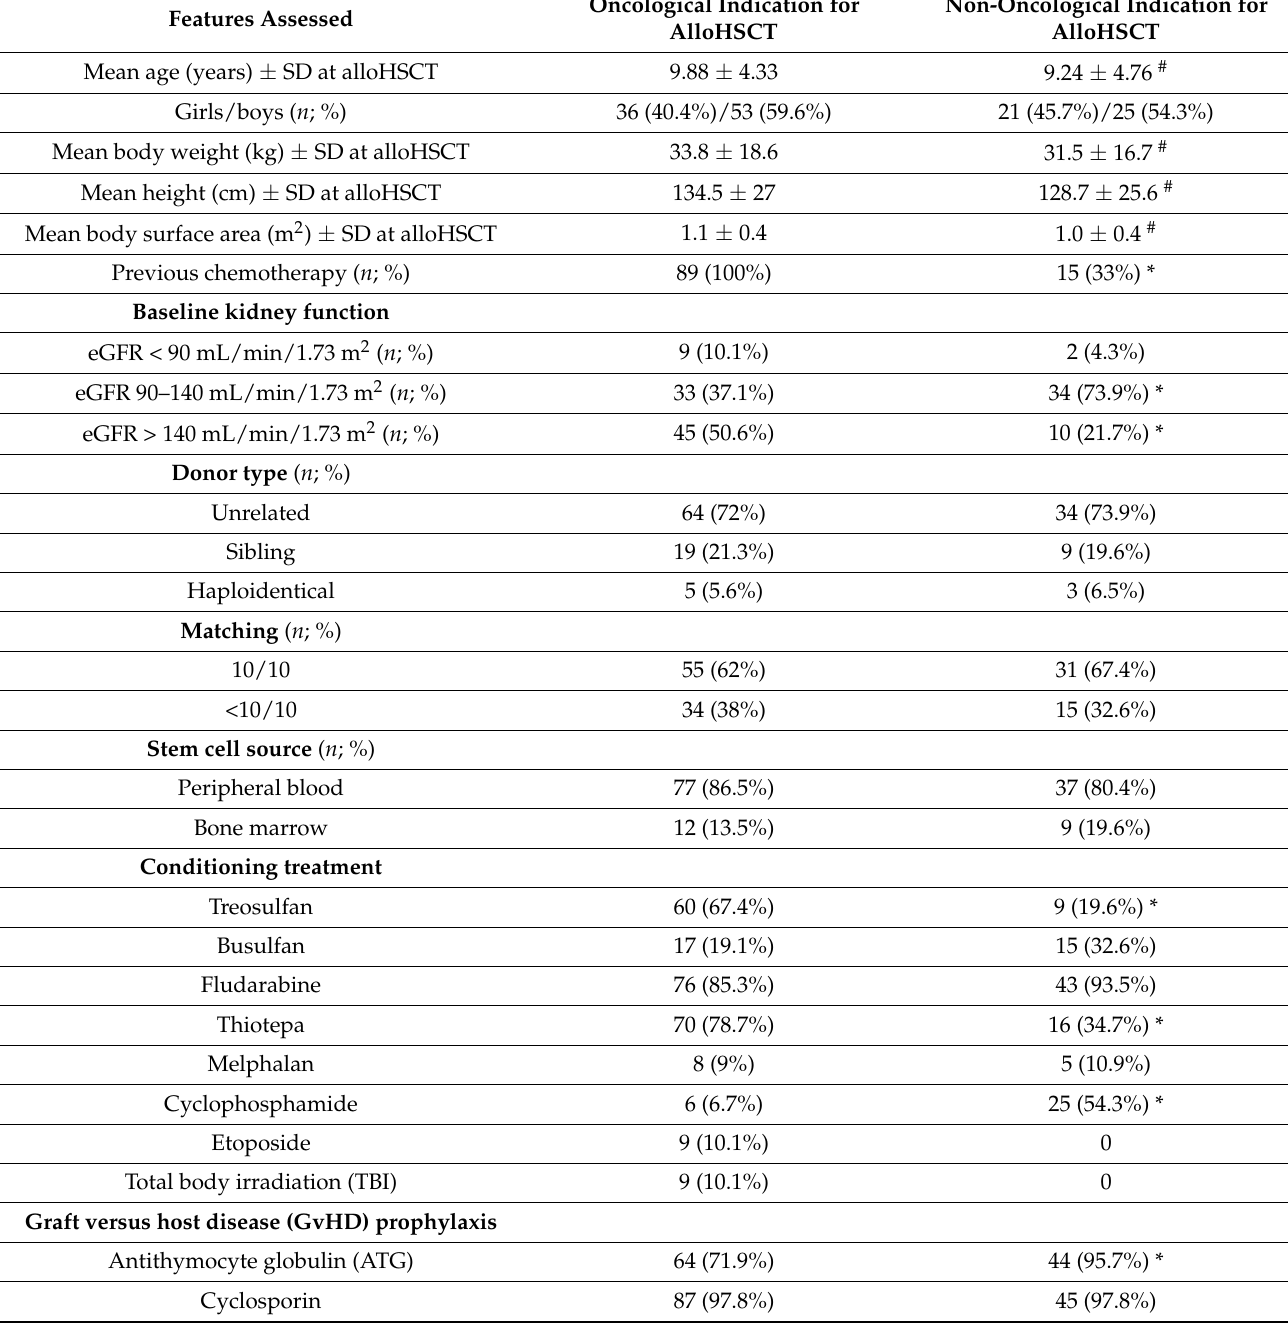
Table 1. Basic demographic and clinical data concerning the studied